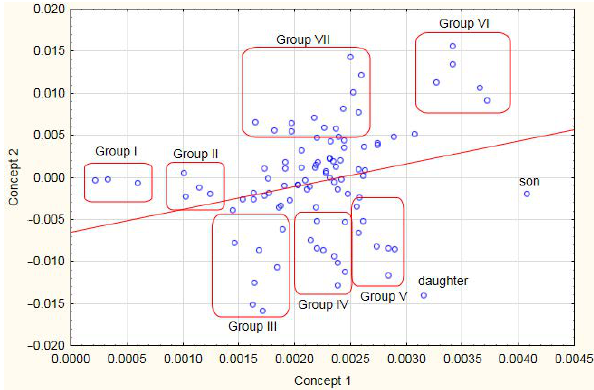
Figure 1. Scatterplot of concepts.